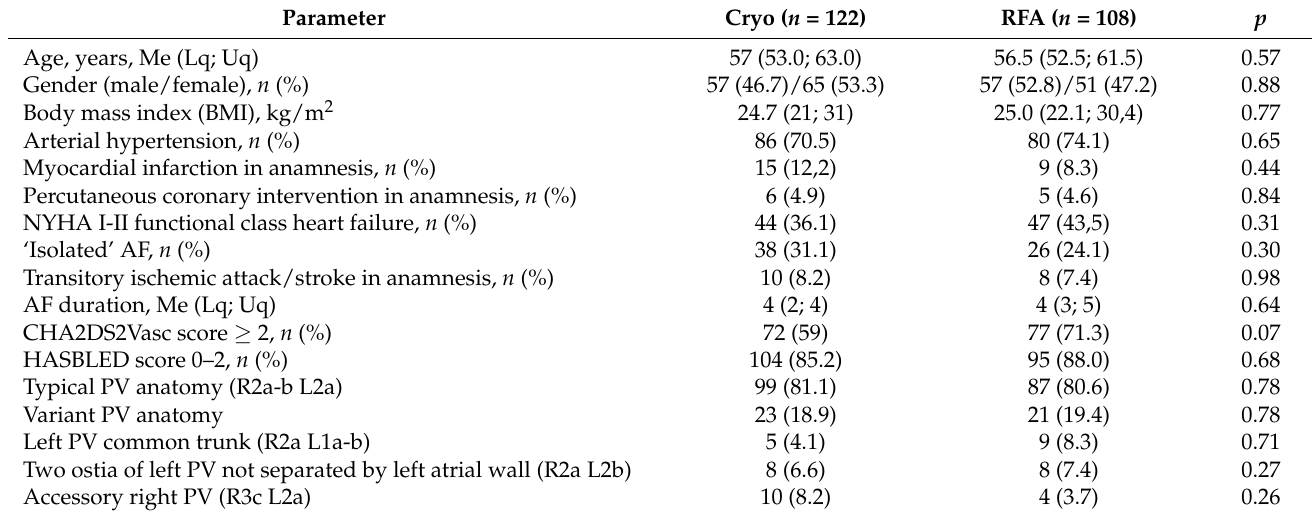
Table 2. Complication’s structure.